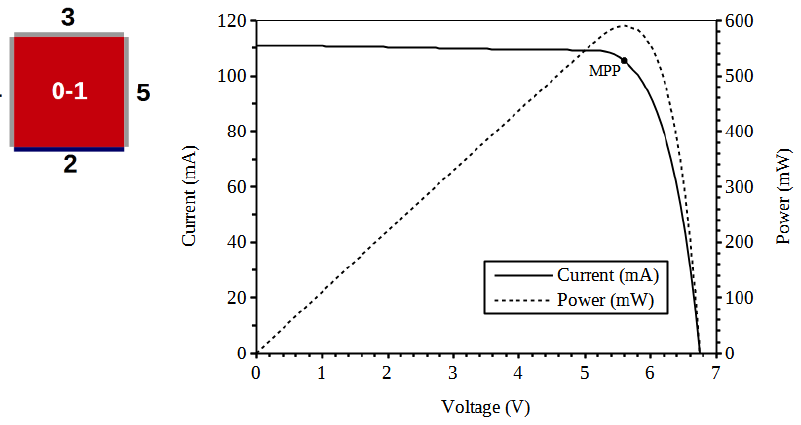
Figure 20. Characteristic curves (I-V and P-V) of the unshaded LSC panel with one 10-cells PV array and functionalized with 300 ppm of Lumogen ® F Red 305.